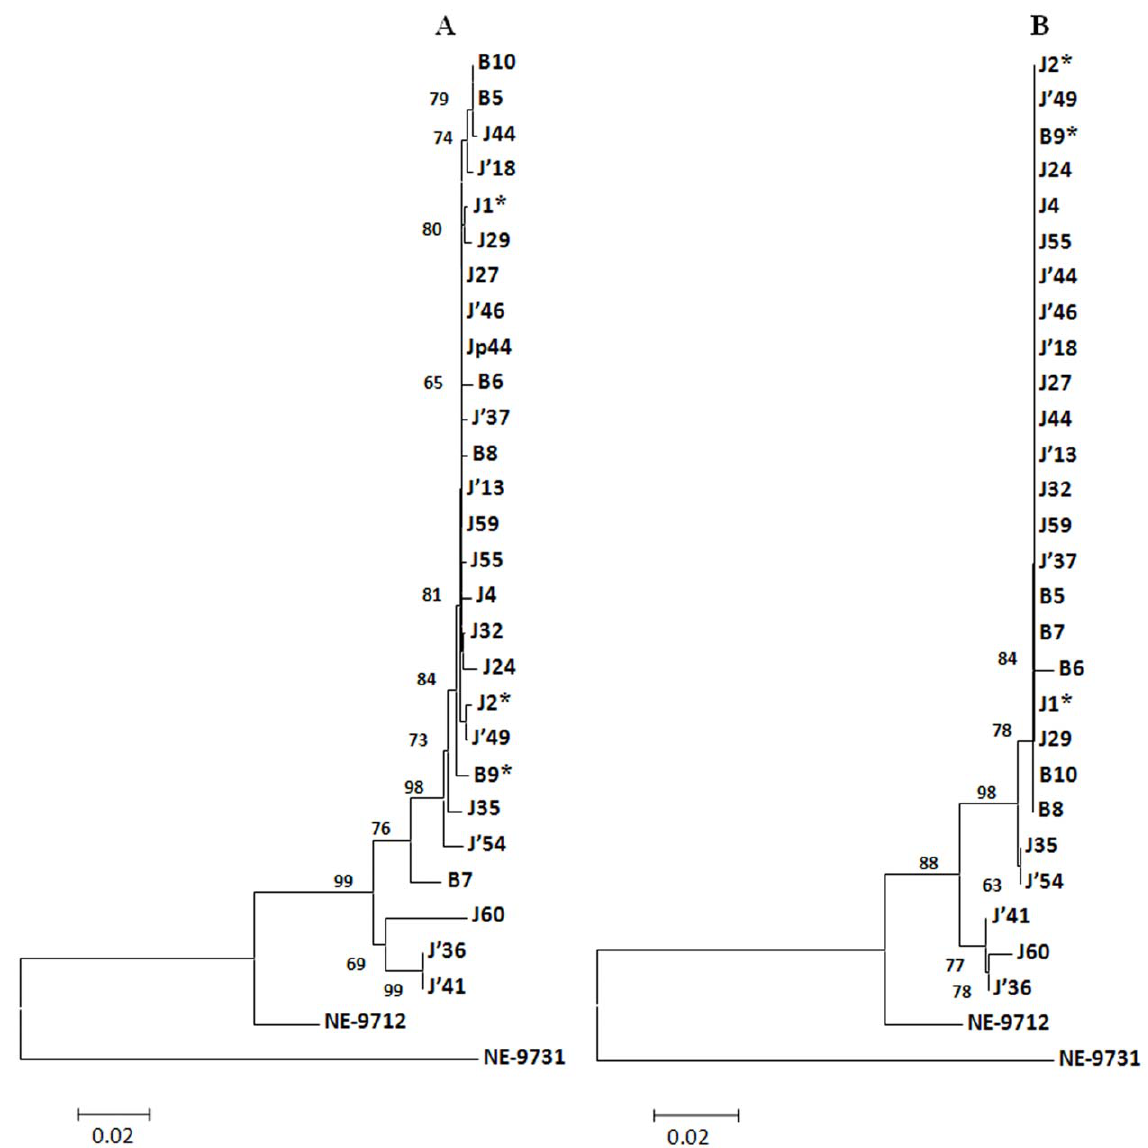
Figure 3. Phylogenetic trees for segment 10 and VP10 of LNV isolates from Xinjiang province. A: Phylogenetic tree based on the nucleotide sequences. B: Phylogentic tree based on the amino acid sequences. Bootstrap values for 500 replications are indicated at each node. The trees were constructed using the Neighbor joining method and the Kimura 2 parameters method (nucleotides) and Poisson’s correction method (amino acids). Similar trees were obtained with the P-distance algorithm. The bar represents the number of substitutions per site. Isolate designations are those reported in table 2. NE-9712 (LNV-NE9712) and NE-9731 (LNV-NE9731) are prototype strains of LNV serotypes 1 and 2, respectively. The letter B in isolates designation refers to Boshikeranmu while J refers to Jiashi county.